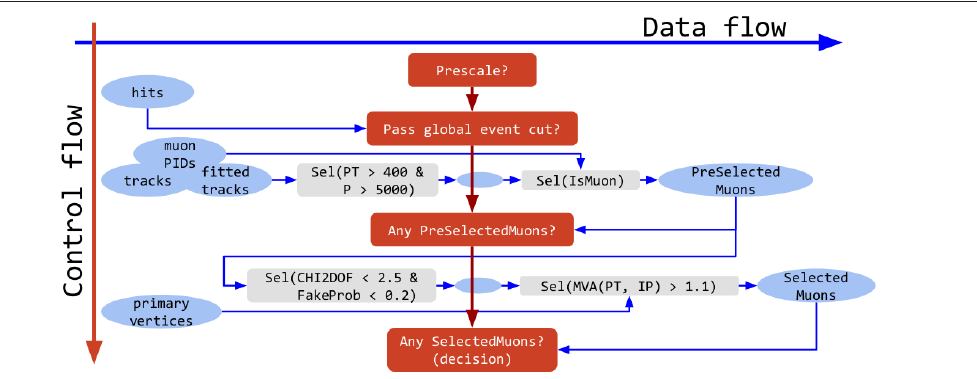
Figure 2. Schematic view of control and data flow defining a selection. Control flow nodes are shown in red, data dependencies in blue and selection algorithms in grey.